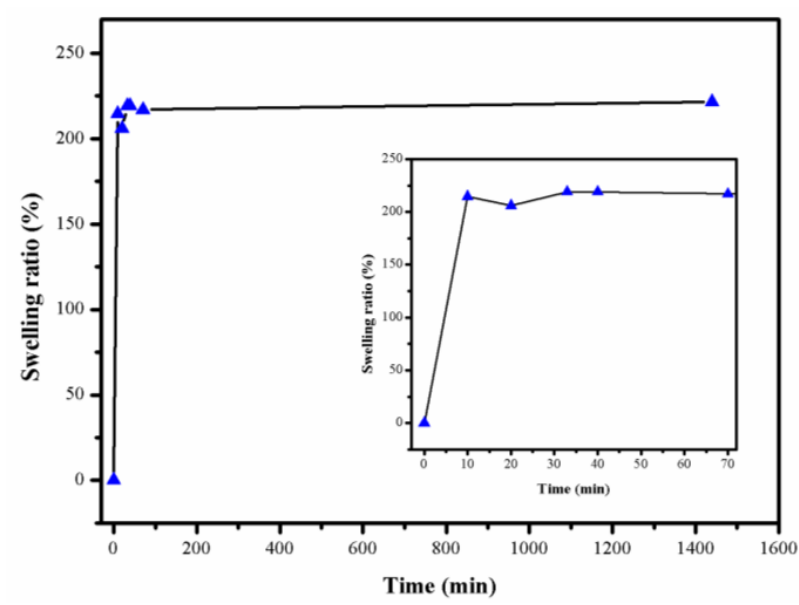
Figure 8. Swelling kinetics of the dried hydrogel cellulose (ECH 7%) in HEMA reagent solution (HEMA, 0.1 HDDA, and Darocur) at T = 20 °C. The inner plot shows aggrandizement for time intervals: 0 to 70 min.